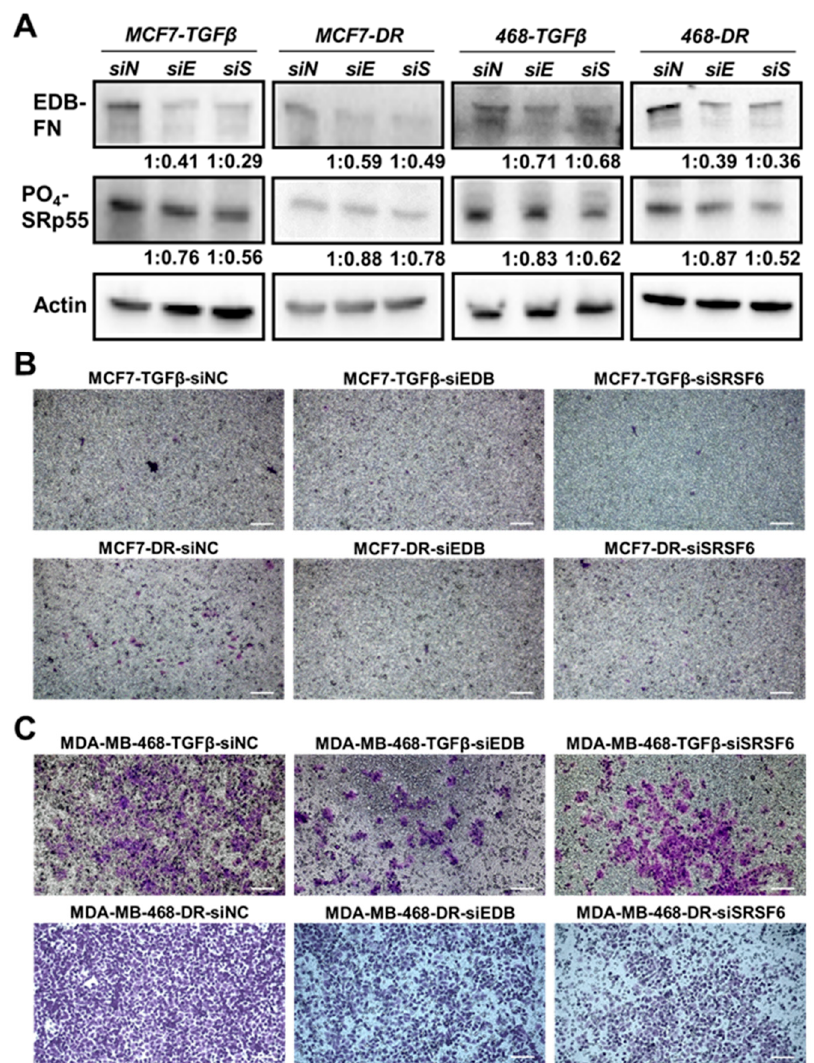
Figure 5 . Depletion of EDB-FN and SRp55 in invasive TGF- β -treated and drug-resistant breast cancer cells reduces their invasion. TGF- β -treated and drug-resistant MCF7 and MDA-MB-468 cells were treated with ECO/siNC (siN), ECO/siEDB (siE), and ECO/siSRSF6 (siS) nanoparticles at 100 nM [siRNA] and N/P = 10. ( A ) Knockdown of EDB-FN and SRSF6 results in downregulation of EDB-FN expression and SRp55 levels with a concomitant reduction in the invasive potential of the invasive TGF- β -treated and drug-resistant ( B ) MCF7 and ( C ) MDA-MB-468 cells. The western blot band intensities were normalized to those of actin bands in FIJI, and the protein level changes are expressed as ratio of siEDB or siSRSF6 over siNC, below the respective lanes. Scale bar = 100 µm.